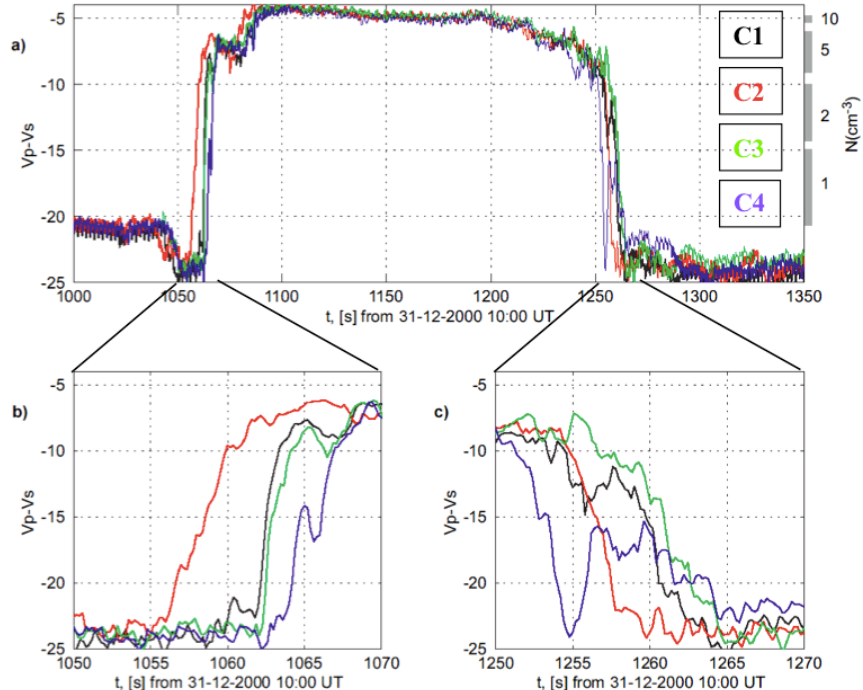
Fig. 6. Top panel: Cluster spacecraft potential measurements as function of time during a magnetopause crossing on 31 December 2000 (from Pedersen et al., 2001). The spacecraft potential can be used as proxy for the plasma density as indicated on the right axis. Bottom panels: zoom around the magnetopause crossings.